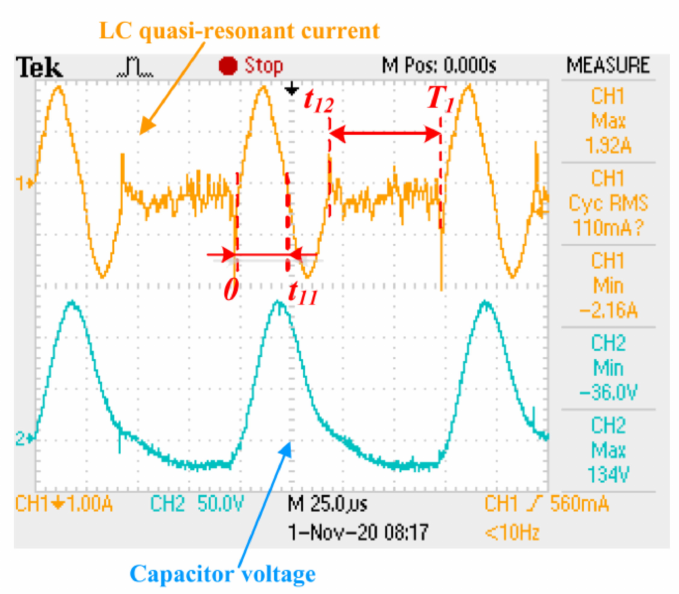
Figure 10. Experimental waveforms of LC quasi-resonant current and capacitor voltage in 13 W, 10 kHz DP2P mode when V BP 2 = V BP 3 = 66.2 V.